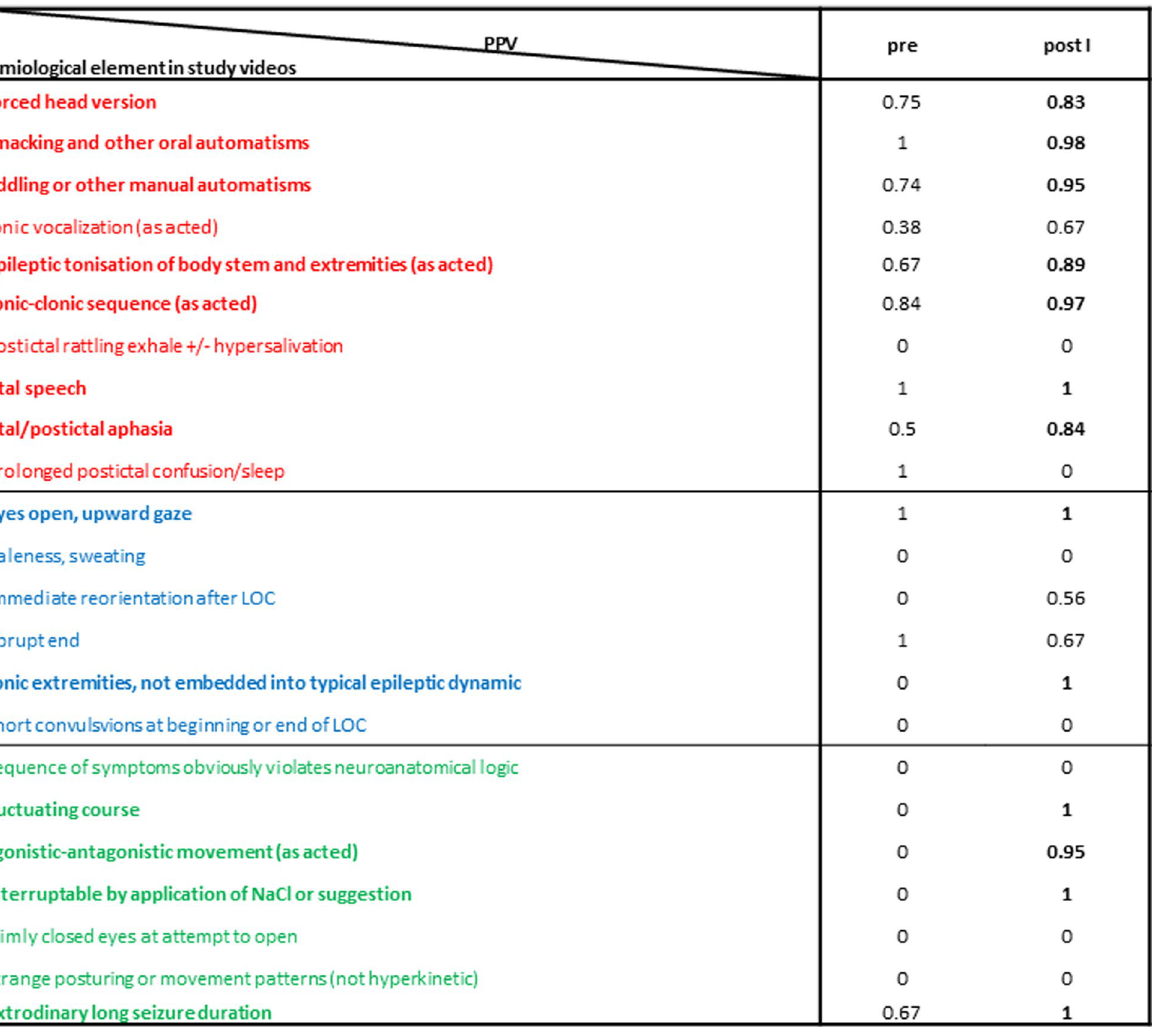
Table 3 PPV of semiological features based on their listing in written